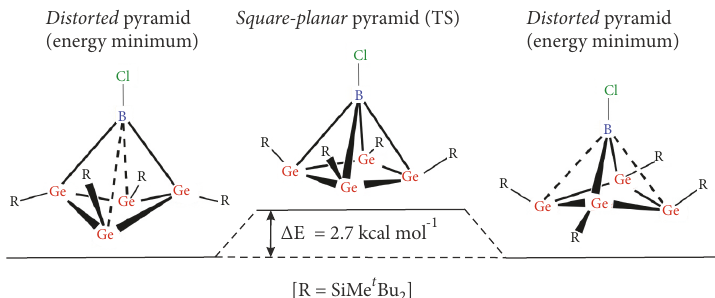
Scheme 1: Conformational interconversion in 7 󸀠